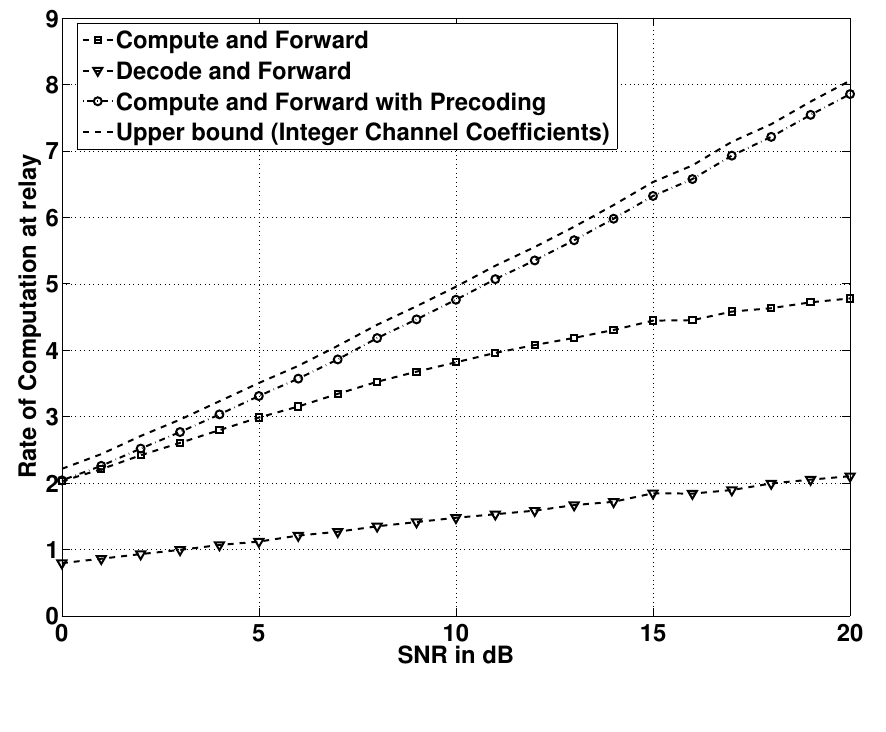
Figure 5. Comparison of achievable rates for various schemes for L = 2 . The average value is taken over 10,000 different random channel realizations. The rates are measured in bits per channel use